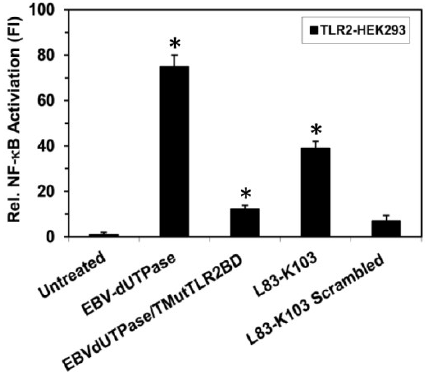
Table 2. TLR2 putative binding